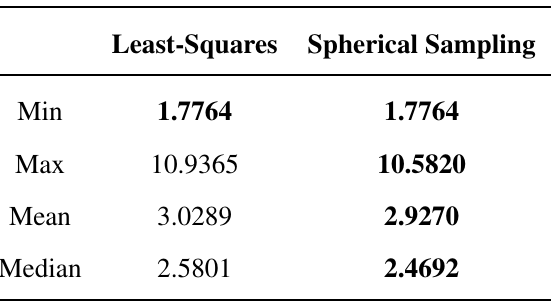
Table 1. ∆ E results: average for 37